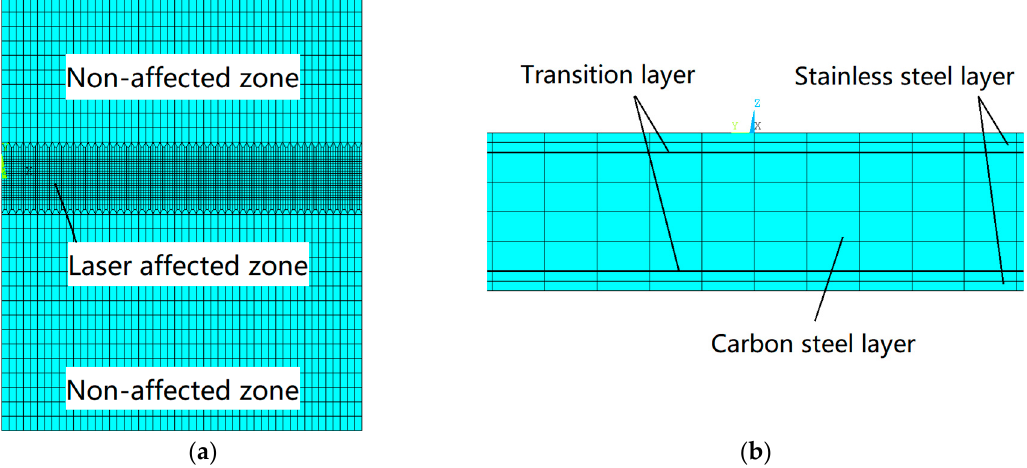
Figure 4. FEM grid partition profile of the SCLP: ( a ) Grid partition in the XOY plane; ( b ) Grid partition in the Z-axis direction.